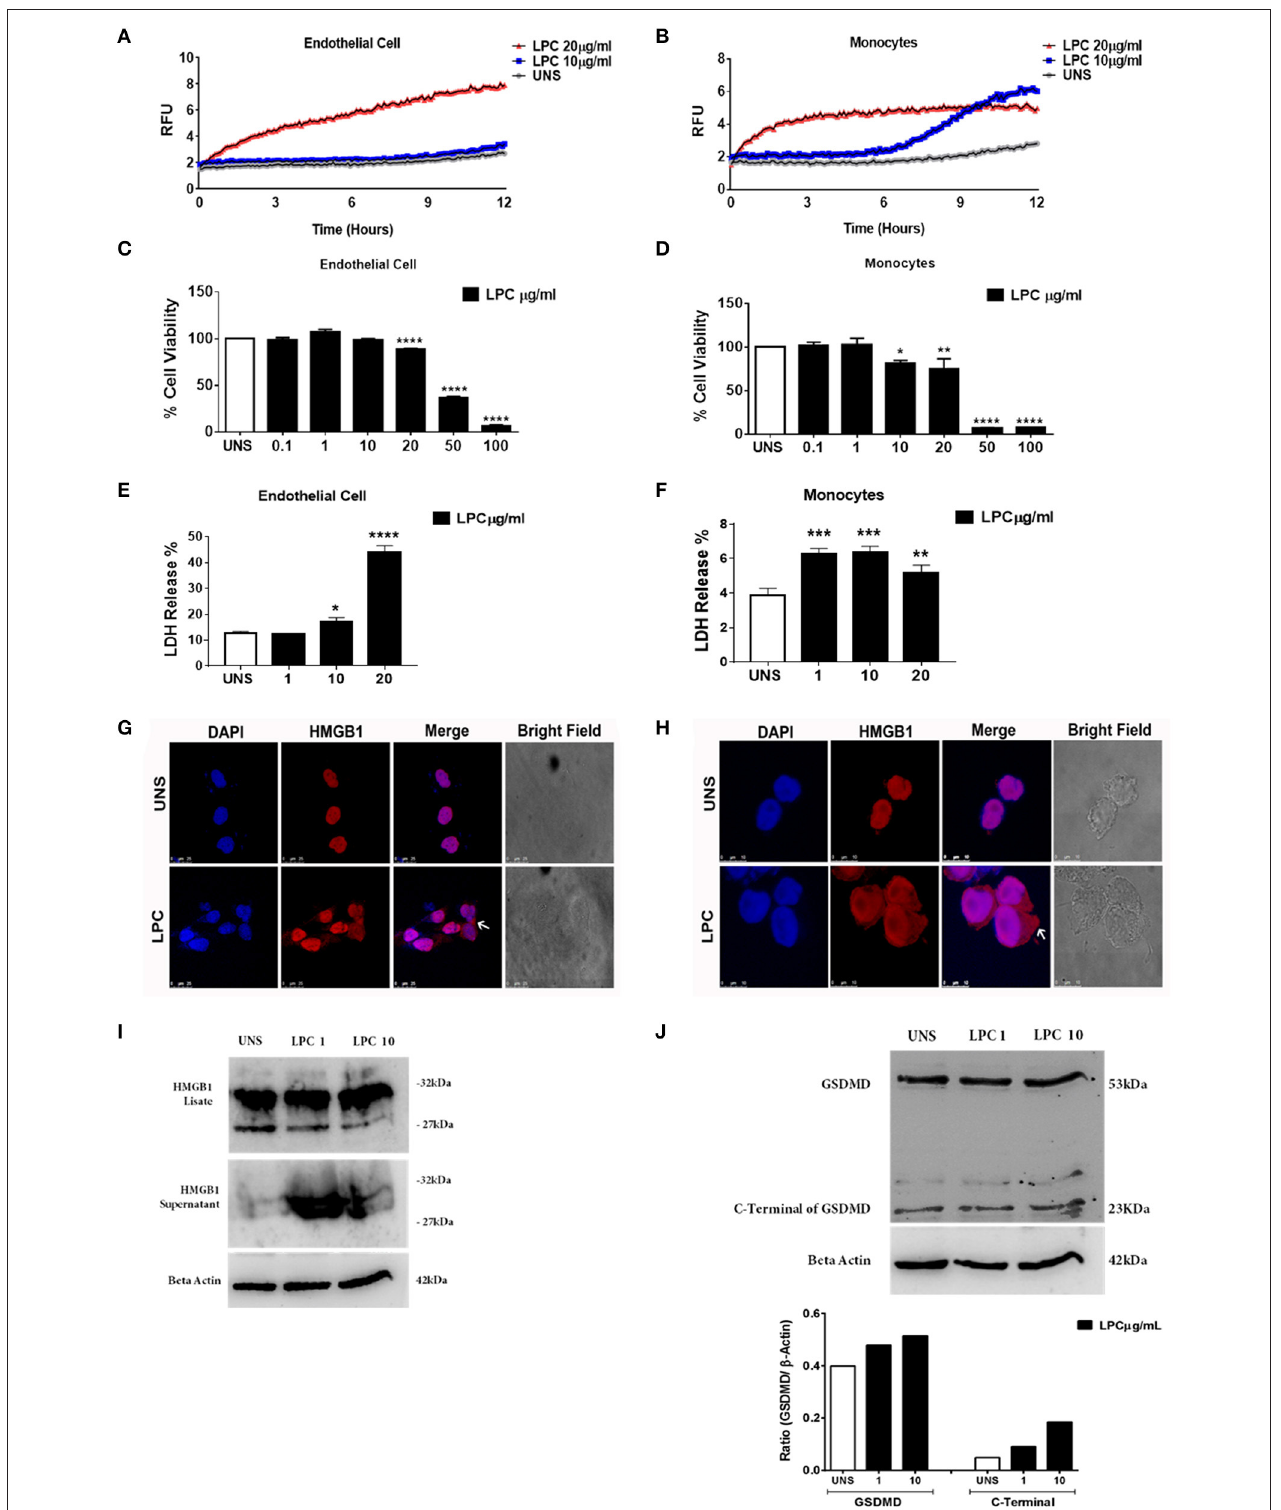
FIGURE 6 | Lysophosphatidylcholine (LPC)-induced pyroptosis in human monocytes and human endothelial cells. (A) Human endothelial cells and (B) human monocytes were stimulated with 10 and 20 µ g/ml of LPC. Pore formation was assessed fluorometrically in real time by the uptake of propidium iodide [relative fluorescence units (RFUs)]. The line represents one experiment performed twice in quintuplicate. (C) Human endothelial cells and (D) human monocytes were